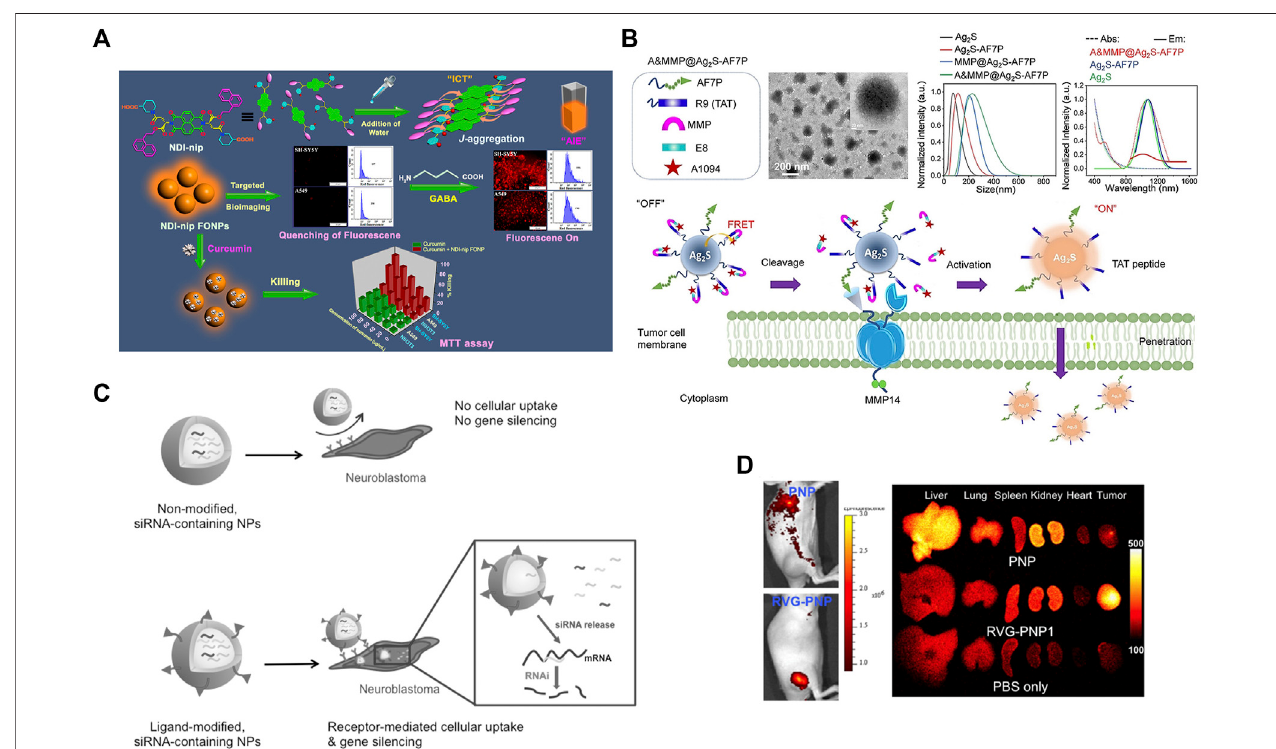
FIGURE 3 | Nanoparticle for optical imaging of NB. (A) Schematic diagram of targeted cell imaging of GABA ( γ -aminobutyric acid)-rich SH-SY5Y cells by NDI- derived FONPs. Reproduced with permission from: Anup Kumar Ghosh, Monalisa Chowdhury, and Prasanta Kumar Das. Nanoparticles as Targeted Delivery Vehicle and Diagnostic Probe toward GABAA-Receptor-Enriched Cancer Cells. ACS applied bio materials, 2021, 4(10): 7563 – 7577 (Ghosh et al., 2021). Copyright 2021, American Chemical Society. (B) Schematic illustration of A&MMP@Ag2S-AF7P for NB detection. Reproduced with permission from (Zhan et al., 2021). Copyright 2020,Wiley-VCHVerlagGmbH&Co.KGaA,Weinheim. (C – D) Ligand-modi fi ed,gene-loadedNPsasatumor-targetingtheranosticagent.Reproducedwithpermission from (Lee et al., 2016b). Copyright 2015, Wiley-VCH Verlag GmbH & Co. KGaA,